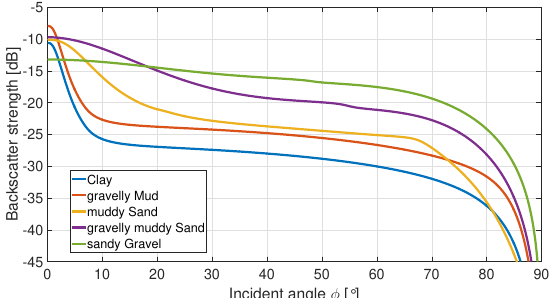
Figure 4. Angular response curves calculated with the APL-model at 100kHz